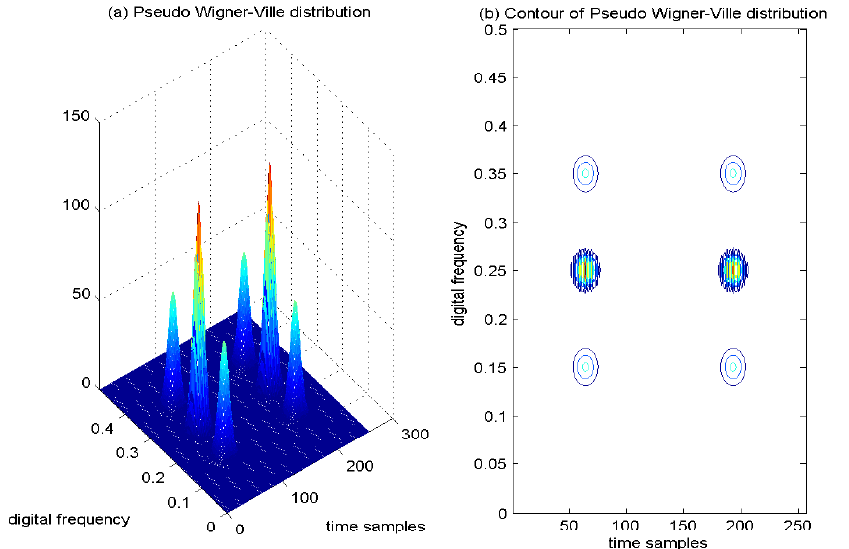
Figure 3. Pseudo Wigner–Ville distribution of four Gaussian components’